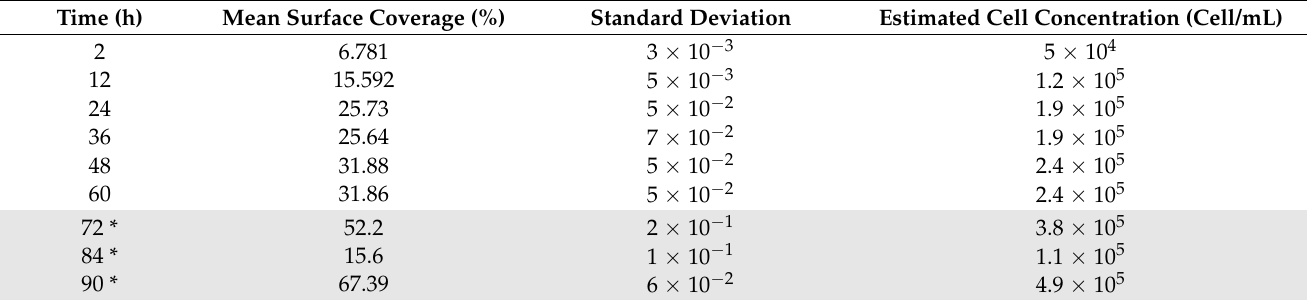
Table 1. Image processing results. The mean values and standard deviations of the surface coverage during the 96 h cultivation time are shown.